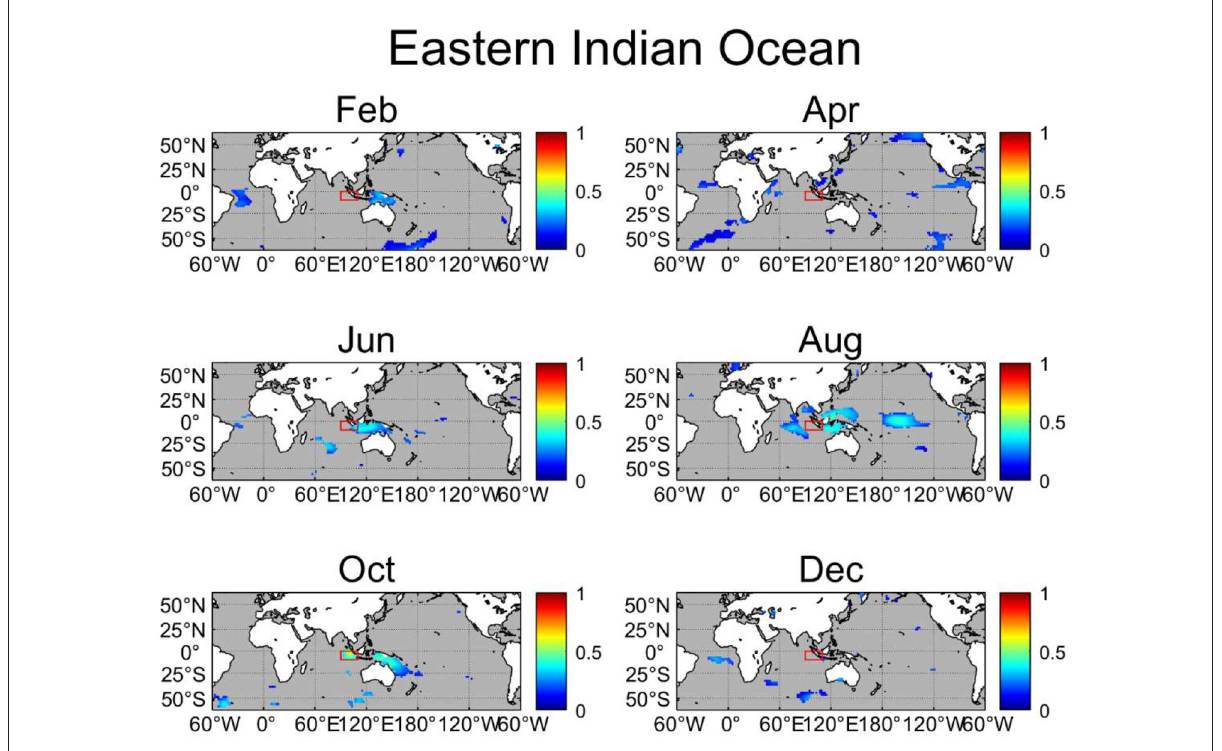
FIGURE10 As in Figure 8, but for the southeastern tropical Indian Ocean (90–110 ◦ E, 10 ◦ S